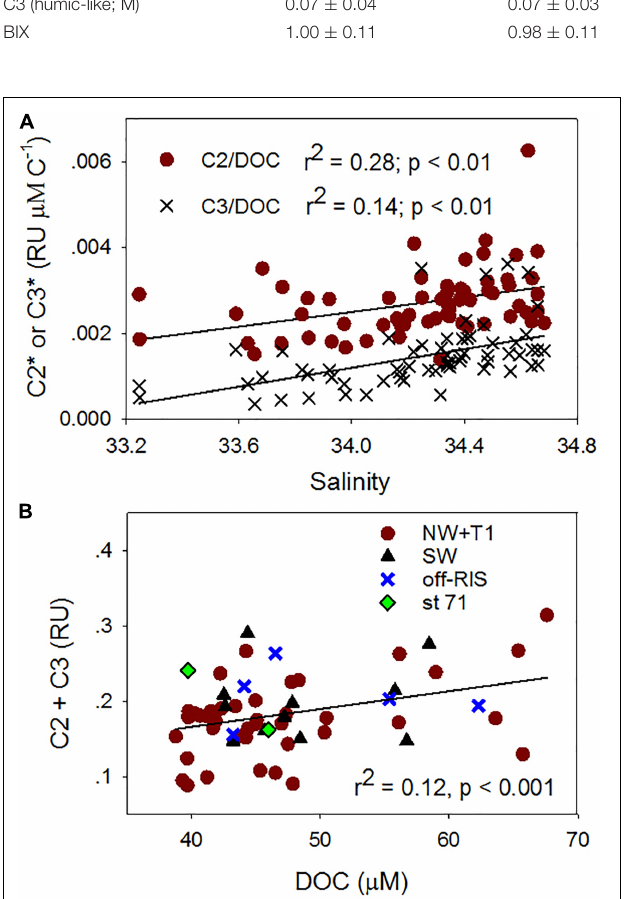
FIGURE 9 | Fluorescent dissolved organic matter (FDOM) relationships. Relationships between (A) salinity and DOC normalized C2 (C2*) and C3 (C3*), (B) DOC and C2 + C3 fluorescent components for samples obtained in the upper water column (e.g., Figure 4 ).